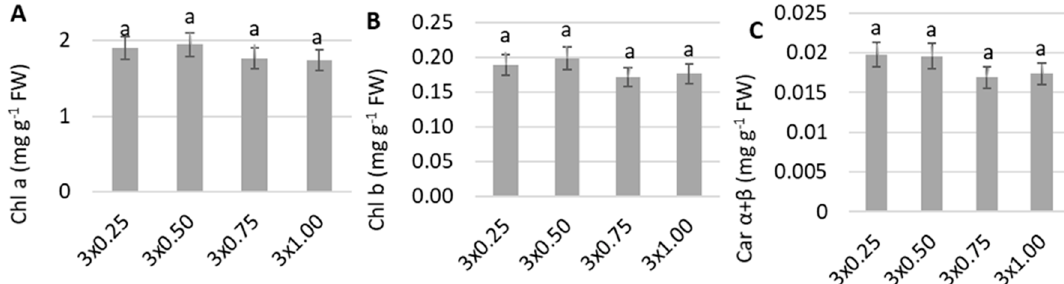
Figure 5. Effect of planting distances regardless distances between trees on chlorophyll a ( A ), chlorophyll b ( B ) carotenes α and β ( C ). The different letters in graphics indicate significant differences. The data were processed using analysis of variance (Anova), the Turkey (HSD) test at the confidence level p = 0.05.